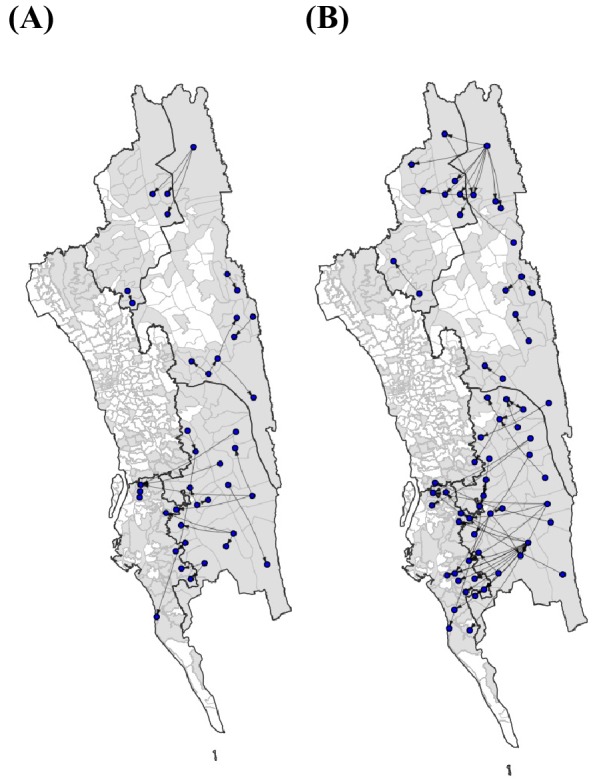
The top routes of importation based on different types of travel.We further analyzed the travel survey to (A) include only work travel, or (B) exclude work travel since this type of travel was quantified per week, as opposed to every 2 months. Similar to all travel, we calculated importations using the incidence values per union. In both instances, the top 25% of routes are shown.